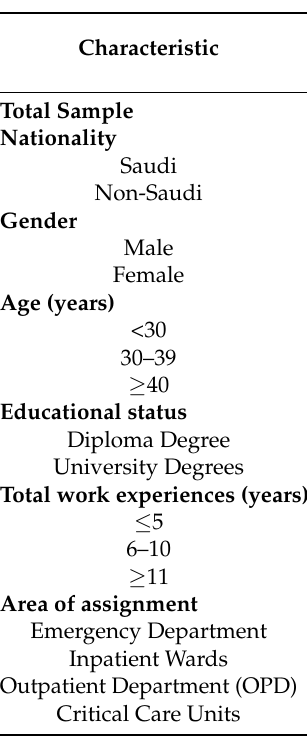
Table 1. Demographic and Educational Characteristics of the